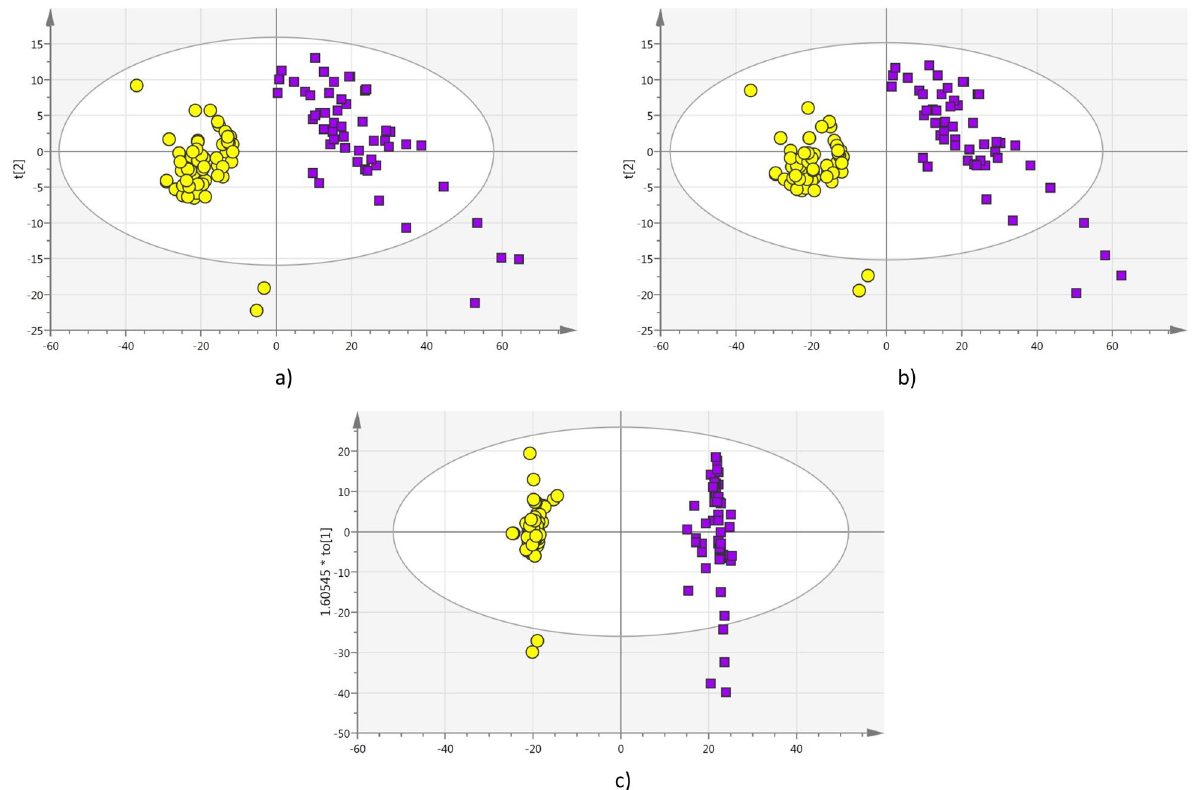
Figure 1. ( a ) PCA Scores plot; ( b ) PLS-DA Scores plot; ( c ) OPLS-DA Scores plot; analysis comparing UV–Vis spectra of apple juice samples (circles) to those of pomegranate juices